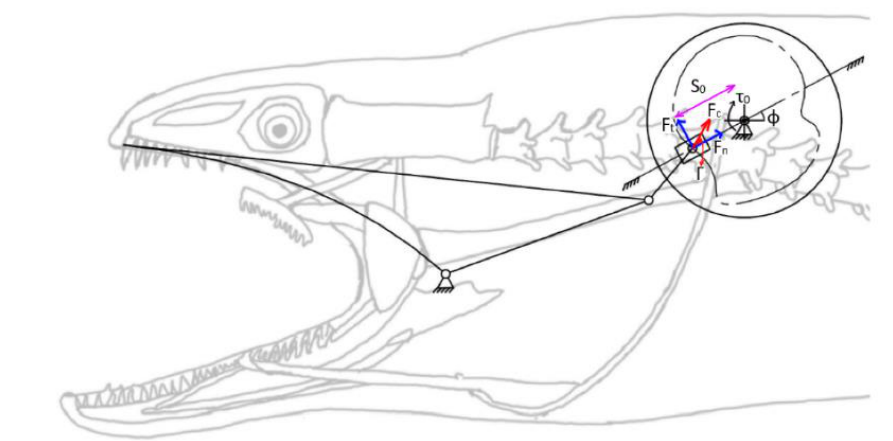
Figure 16. Force vectors of the cam profile on the oral jaw